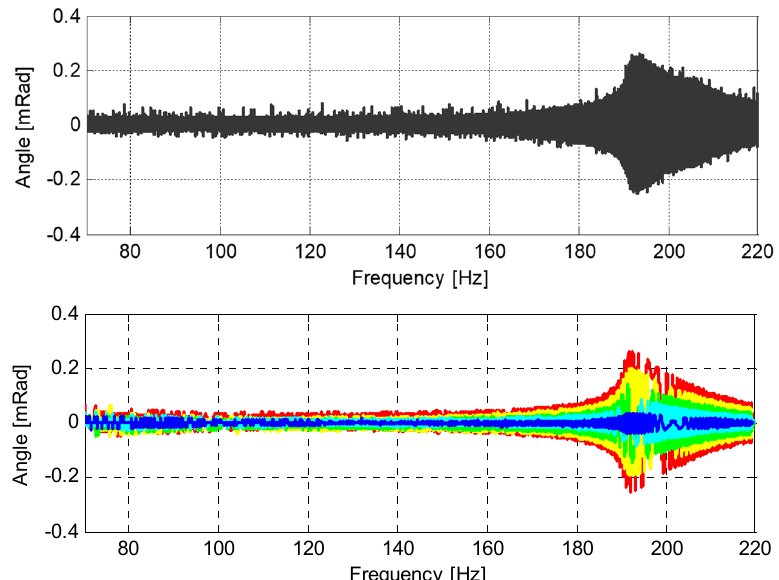
Figure 16. The results of RC testing. Standard RC test results are at the top; the results from the